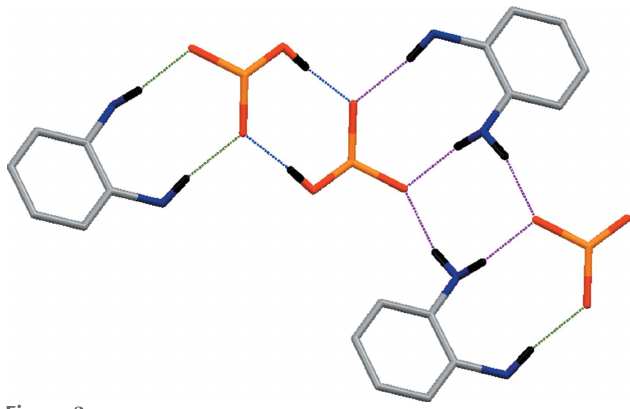
Figure 3 A partial view of the crystal packing showing different ring motifs.